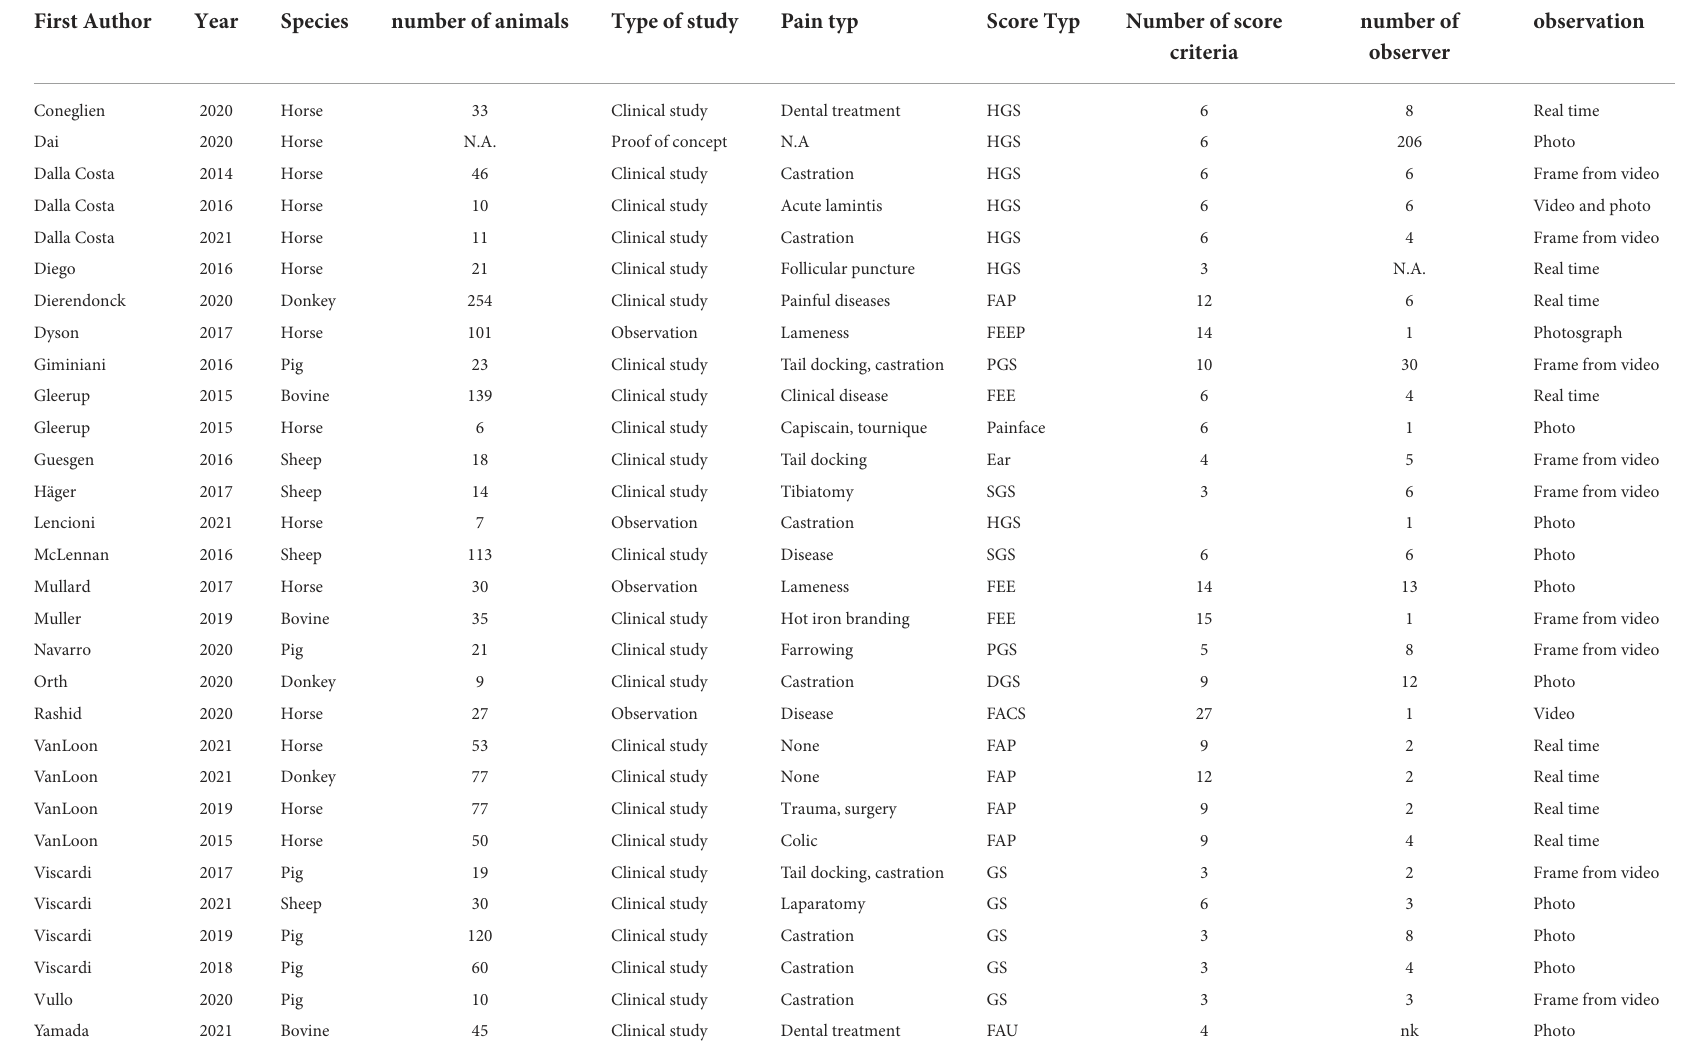
TABLE 1 General characteristics of articles ( n = 30) included in this